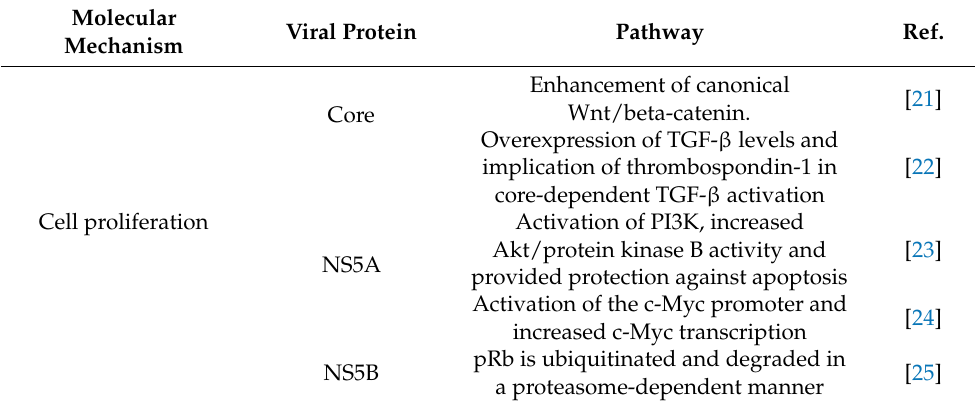
Table 2. Molecular mechanisms by HCV proteins-induced